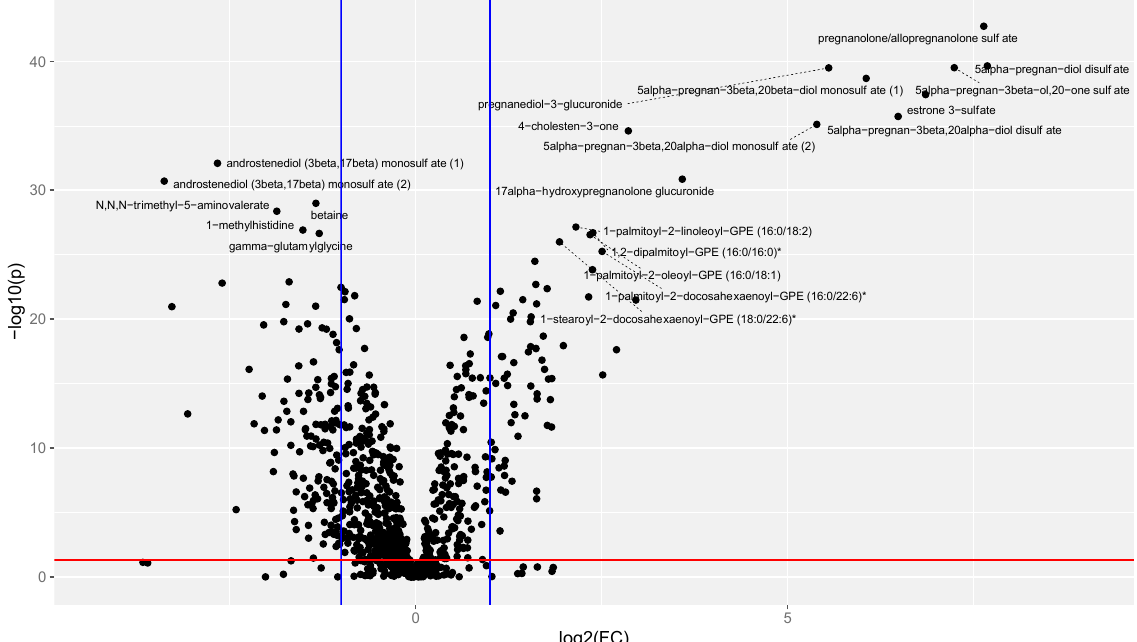
Figure 2. Volcano plot representing the magnitude and significance of changes observed with − log10( p -value) on the y-axis and log2(Fold Change (FC)) on the x-axis. The cutoff of the significance value of p < 0.05 is noted with the horizontal red line and the thresholds for fold change values of greater than 2 or less than 0.5 are noted with vertical blue lines. Each point represents a single metabolite. Metabolites with a − log10( p ) > 25 are labeled with their chemical name.